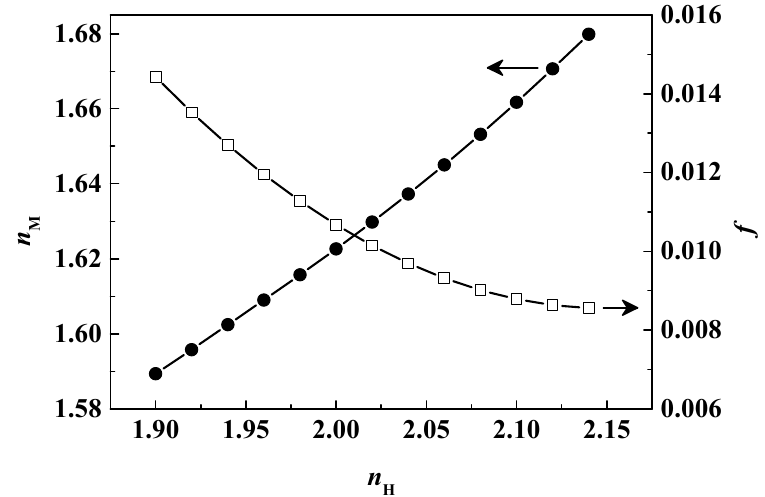
Figure 1. Optimized refractive indices of the bottom layer n M and objective function f versus refractive indices of the middle layer n H . The refractive index of the top layer is set to be 1.44 and the central wavelength is 550 nm. The optical thicknesses of the triple-layer AR coating onto fused quartz are quarter-half-quarter.